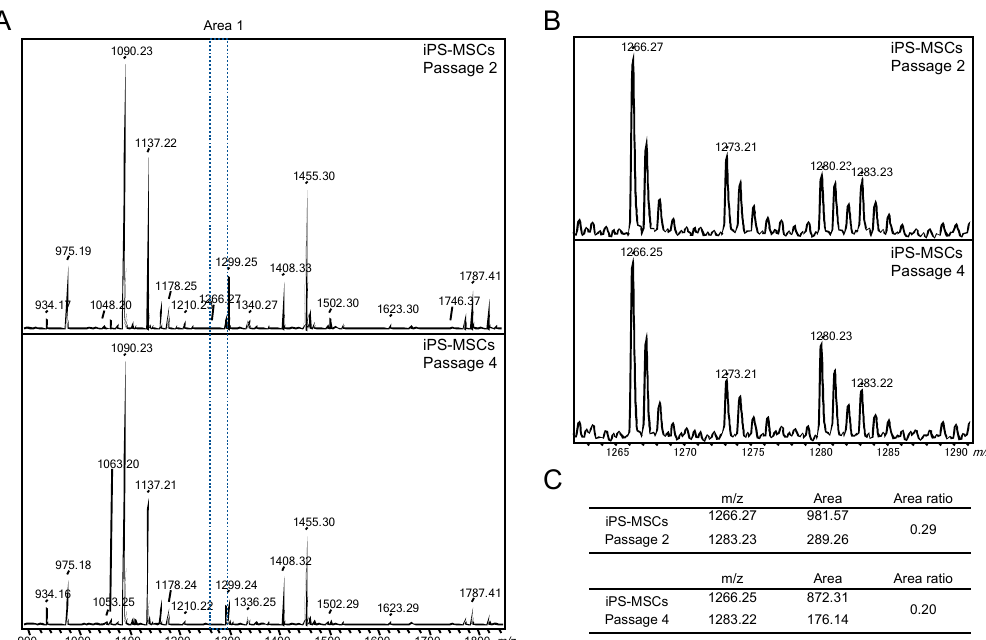
Figure 7. ( A ) MALDI-TOF MS spectra of GSL-glycans in passage 2 and 4 iPS-MSCs. ( B ) Close-up views in Area 1. ( C ) The area ratio of m / z 1283 and m / z 1266 in passage 2 and 4 iPS-MSCs.